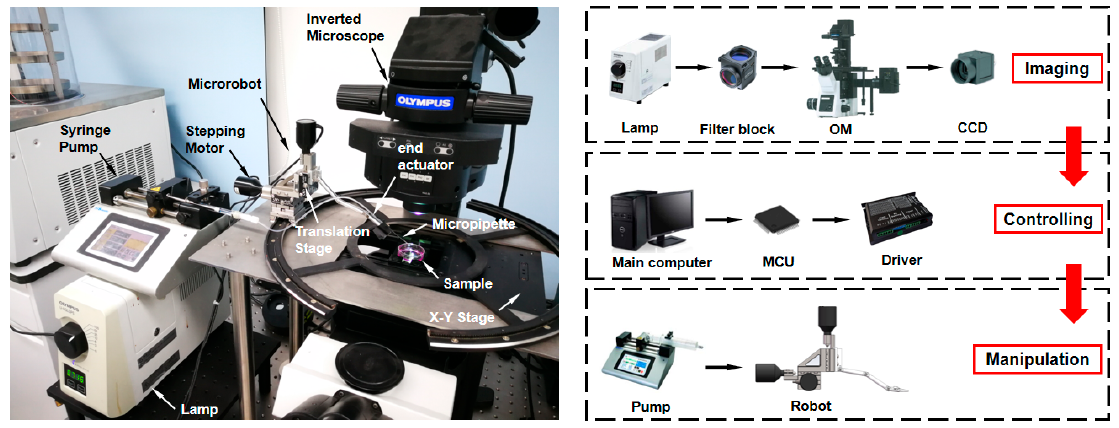
Figure 7. Automated microrobotic manipulation system.